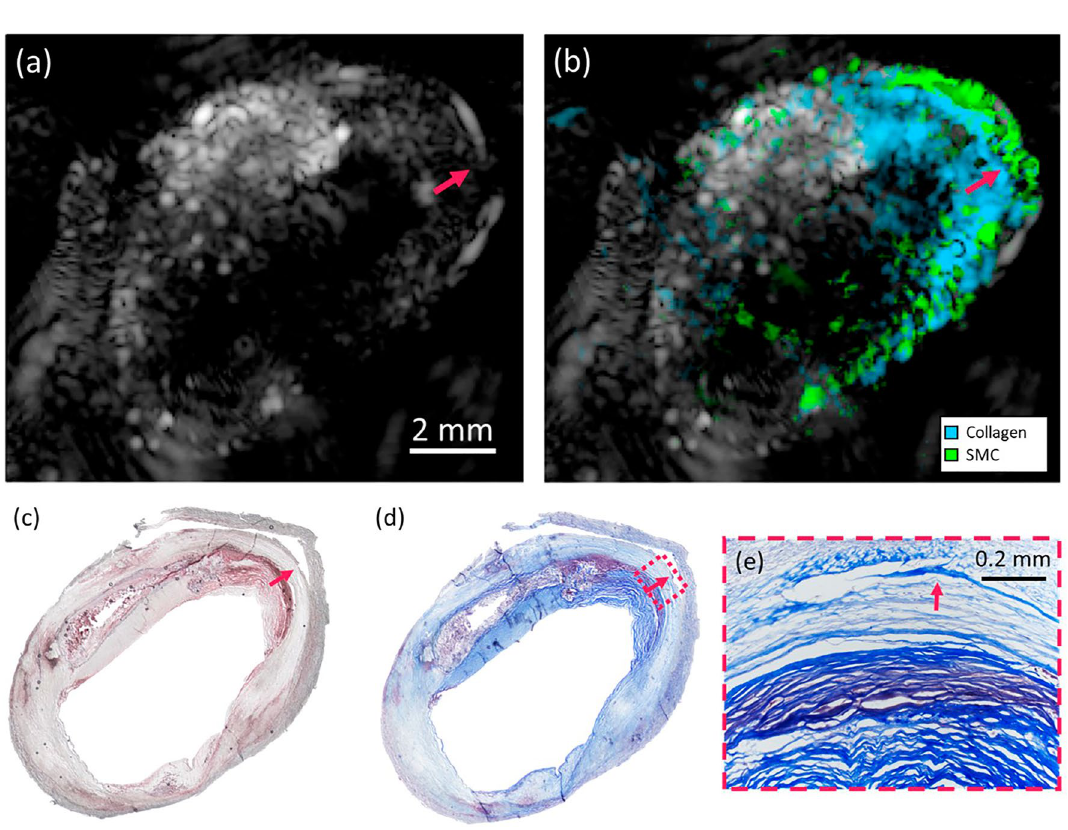
Figure 4. Endarterectomy plaque with low lipids concentration. ( a ) is the US image and ( b ) is the proportion map for collagen and SMC using selected wavelengths. ( c ) Shows the ORO staining of the sample, indicating low lipid content. ( d ) MT staining, there is an interface that indicates the presence of collagen in the imaged region. ( e ) MT stain (magnification × 100) shows a decrease in collagen content near the material interface, which is effectively detected in the proportion map ( c